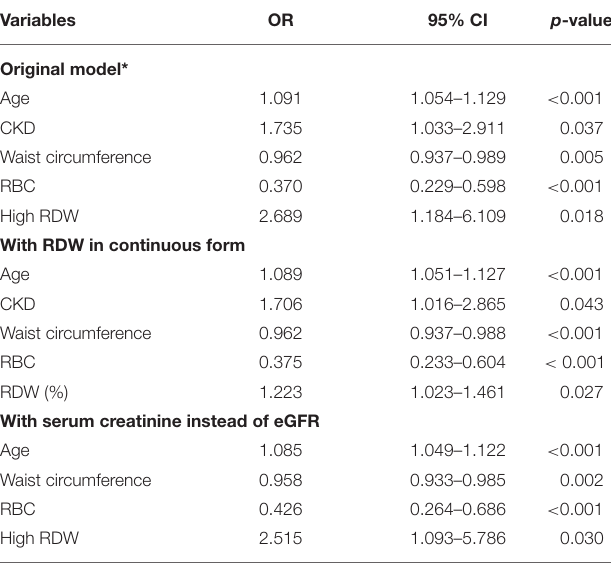
TABLE 3 | Results from multiple logistic regression with the presence of frailty as the outcome of interest. Variables OR 95% CI p